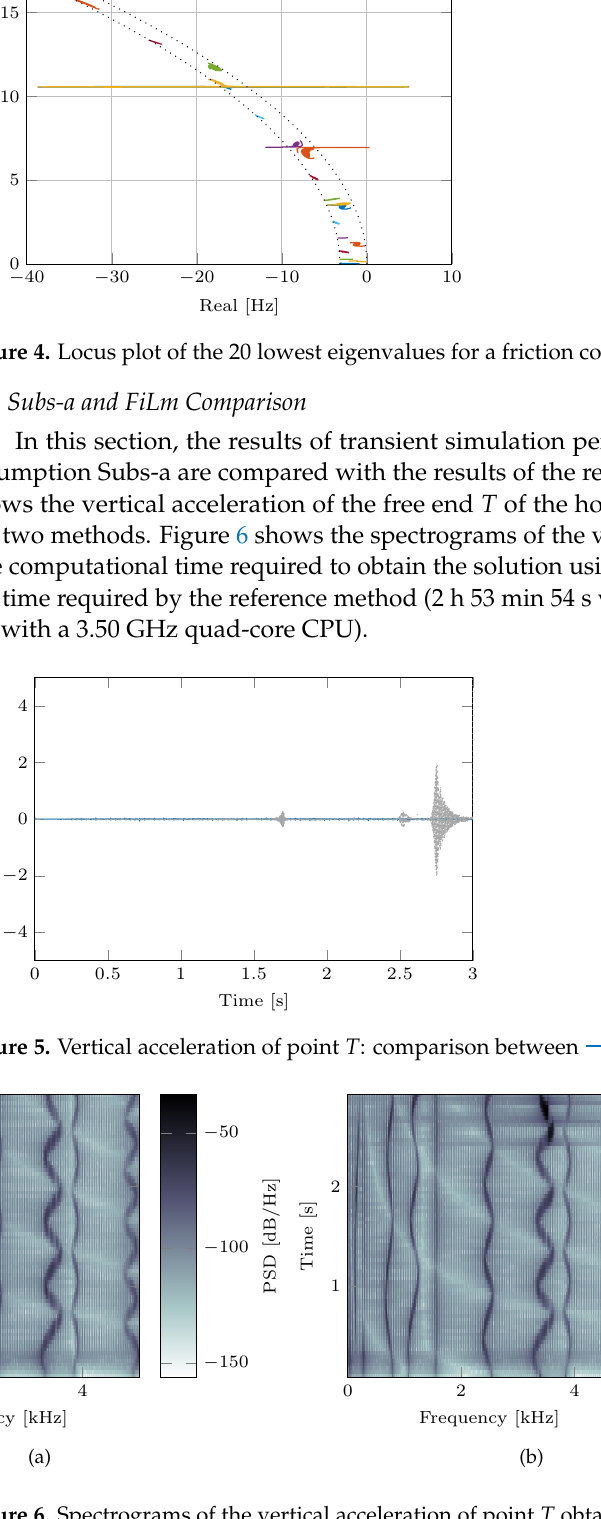
Figure 6. Spectrograms of the vertical acceleration of point T obtained using the Subs-a ( a ) and FiLm ( b )